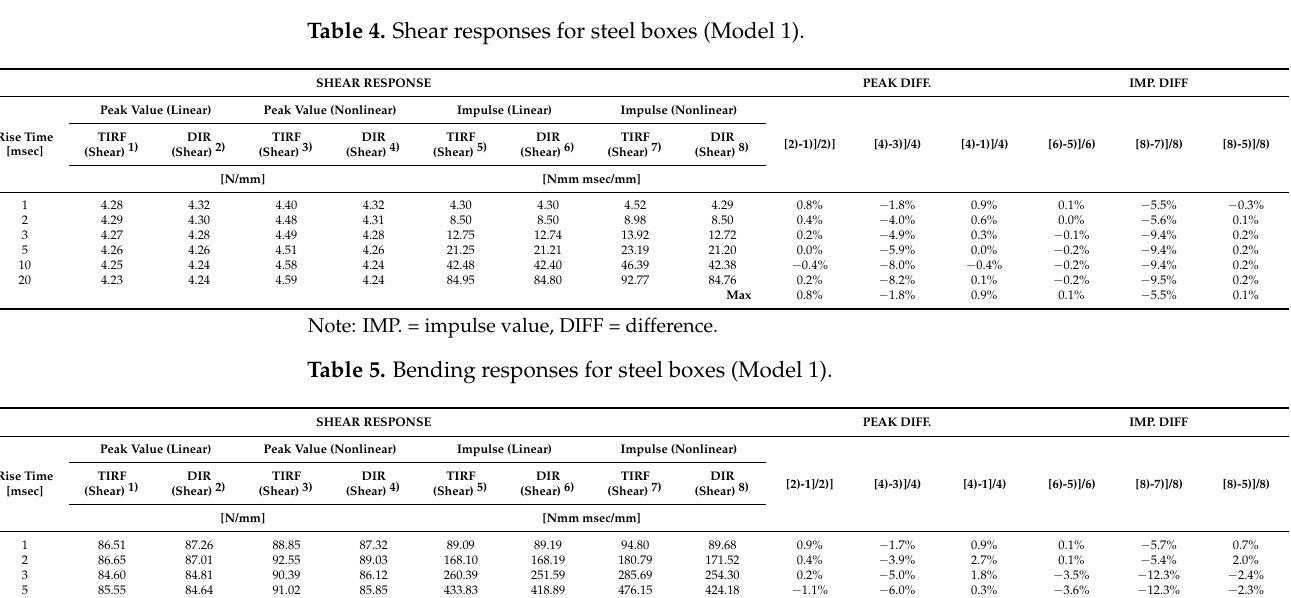
Figure 9. Reference shear and bending responses using TIRF and DIR for impact pressure of 10.0 ms of rise time: ( a ) Reference shear responses with linear boundary conditions, ( b ) Reference bending responses with linear boundary conditions, ( c ) Reference shear responses with nonlinear boundary conditions, and ( d ) Reference bending responses with nonlinear boundary conditions. Table 4. Shear responses for steel boxes (Model 1).